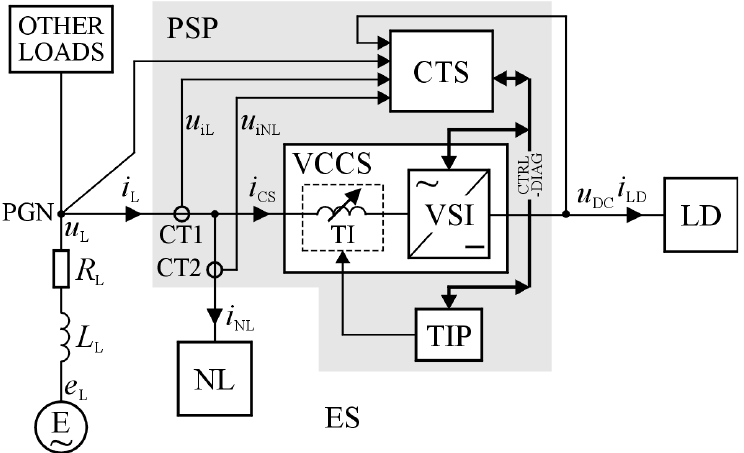
Figure 1. Block diagram of an electrical system containing a PSP equipped with a compensation function.